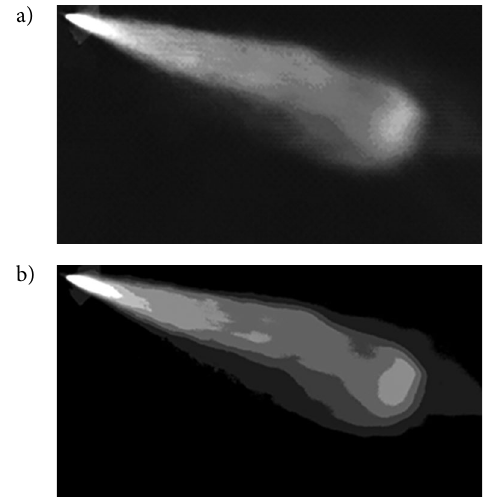
Figure 3. Fragments of recording the image of the fuel atomi- zation process (image inverted): a – initial image (exposure time 35.5 μ s; b – brightness zones, allocated by the computer program on the image using the threshold segmentation